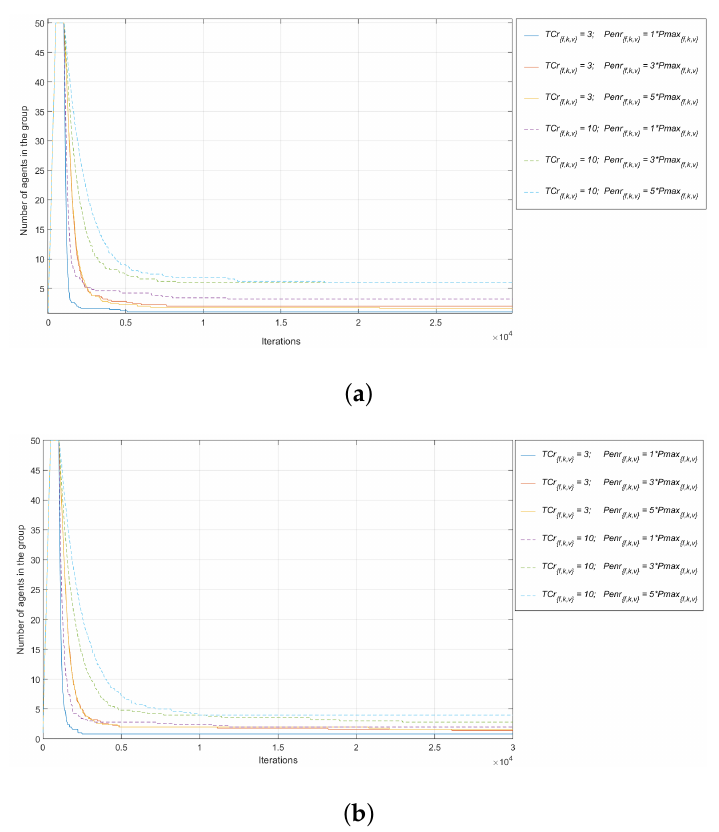
Figure 9. Removing agents from the group with dependence on TCr { f , k , v } and Penr { j , m , i } ; the simulation lasted for 30,000 iterations; 50 agents were added into the group in the 1000th iteration: Pmax { f , k , v } = 400, TRr { f , k , v } = 200 ( a ), and TRr { f , k , v } = 400 ( b